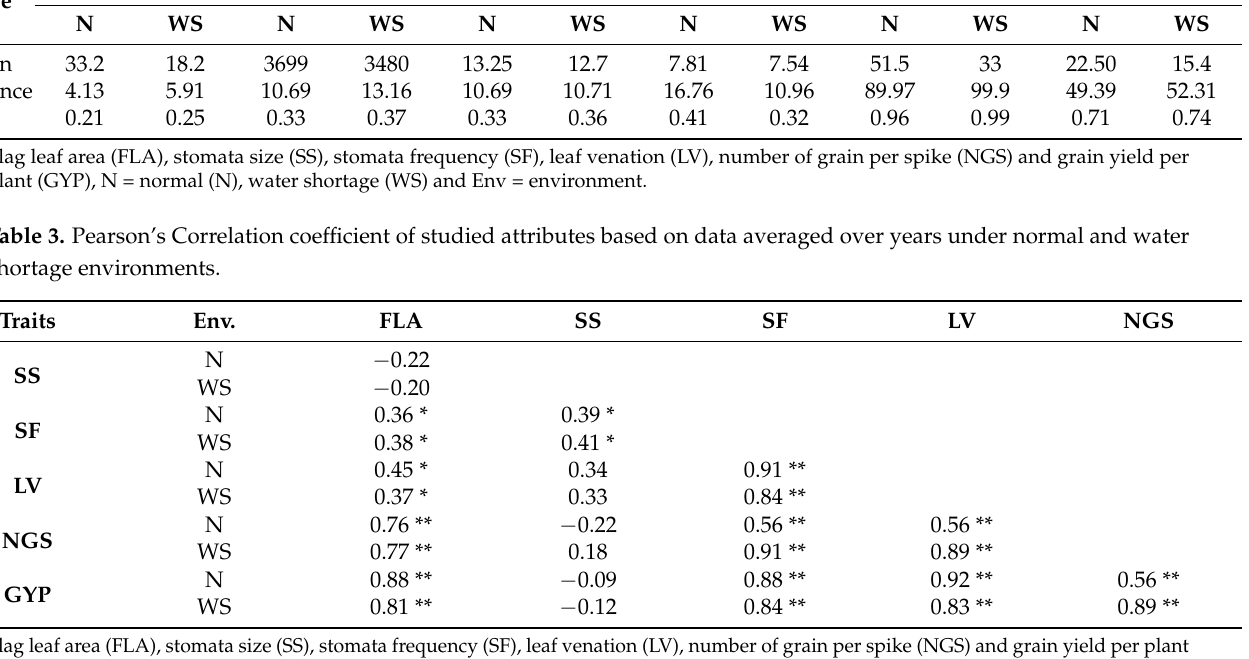
Flag leaf area (FLA), stomata size (SS), stomata frequency (SF), leaf venation (LV), number of grain per spike (NGS) and grain yield per plant (GYP), N = normal (N), water shortage (WS) = water shortage, Env = environment, * = Significant ( α = 0.05) and ** = Highly significant ( α =